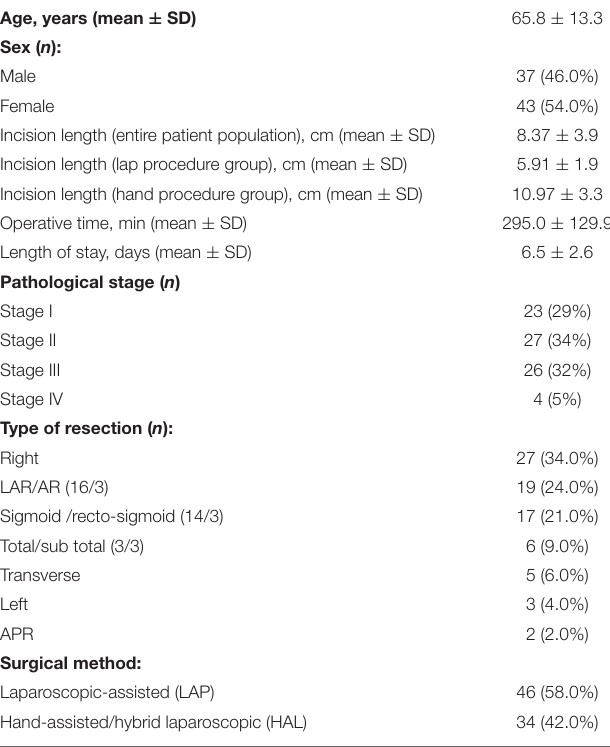
TABLE 1 | Demographic and clinical characteristics of the study population. Age, years (mean ±